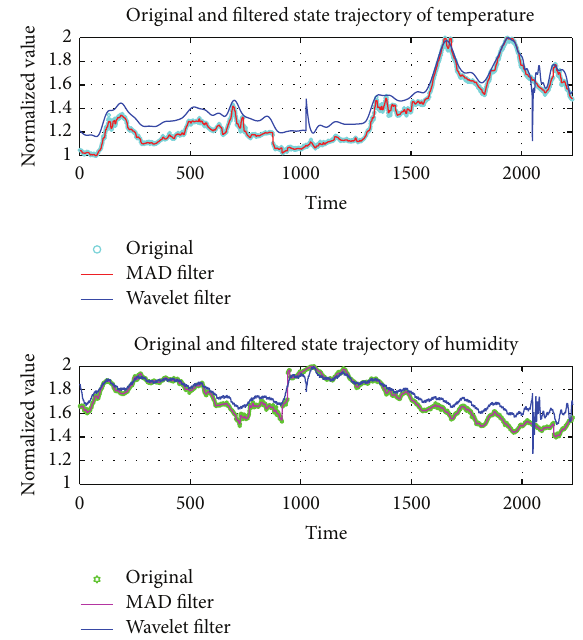
Figure 3: State trajectories refer to the 3rd variable and 4th variable.